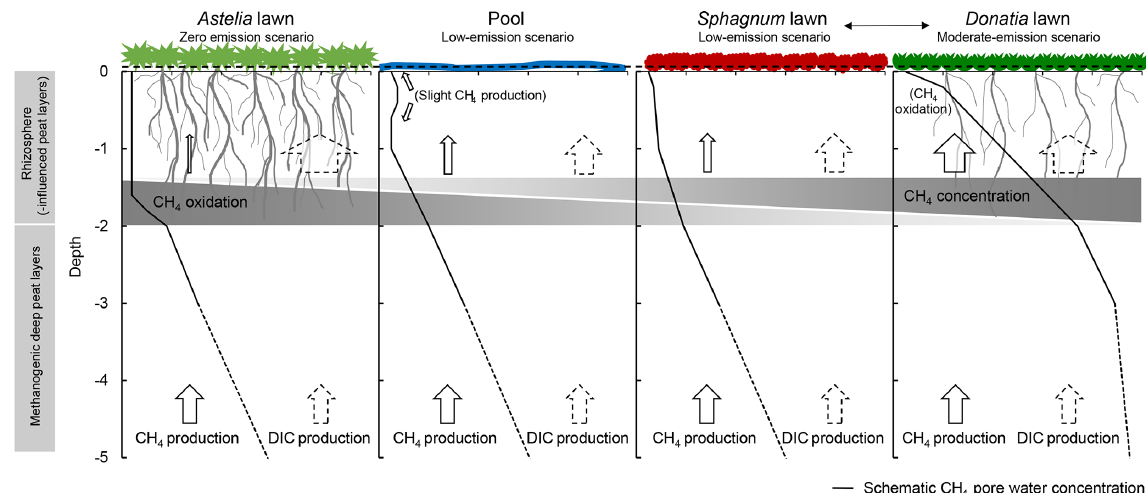
Figure 6. Schematic CH 4 concentration profiles below the four dominant microforms in a Patagonian cushion bog. The shape of profiles was derived from data obtained in the present study together with those by Limpens et al. (2008), Fritz et al. (2011) and Broder et al. (2015). The size of arrows represents the relative magnitude of either a CH 4 or CO 2 flux following the diffusion gradient. The water table position is displayed by a dashed line near the surface. CH 4 oxidation by root O 2 release resulted in near-zero CH 4 pore water concentrations in densely rooted peat below Astelia lawns. With increasing distance from densely rooted peat, CH 4 oxidation decreased while CH 4 concentration in- creased until reaching a depth profile typical for those of northern peatlands with fewer if any roots in water-saturated peat layers. Exemplary sequence of microforms, derived from observed amounts of emitted CH 4 . Other sequences of microforms are reasonable as microforms occur in various combinations in the